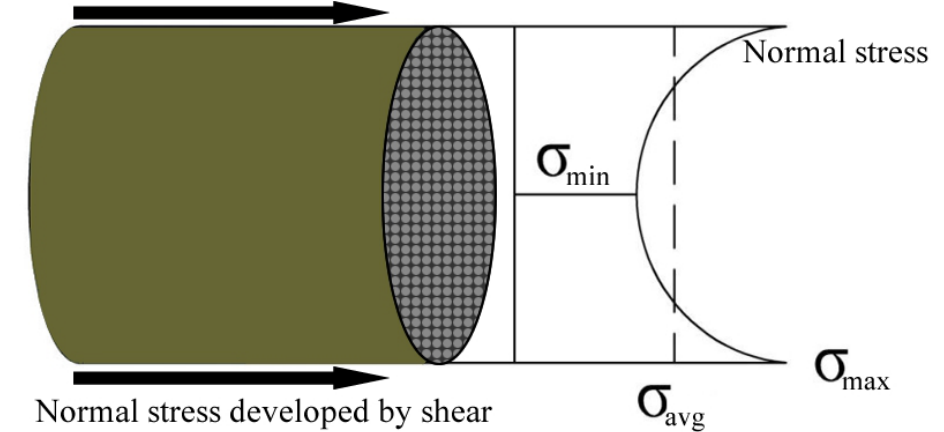
Figure 2. Shear lag effect (modified from [19,21]).